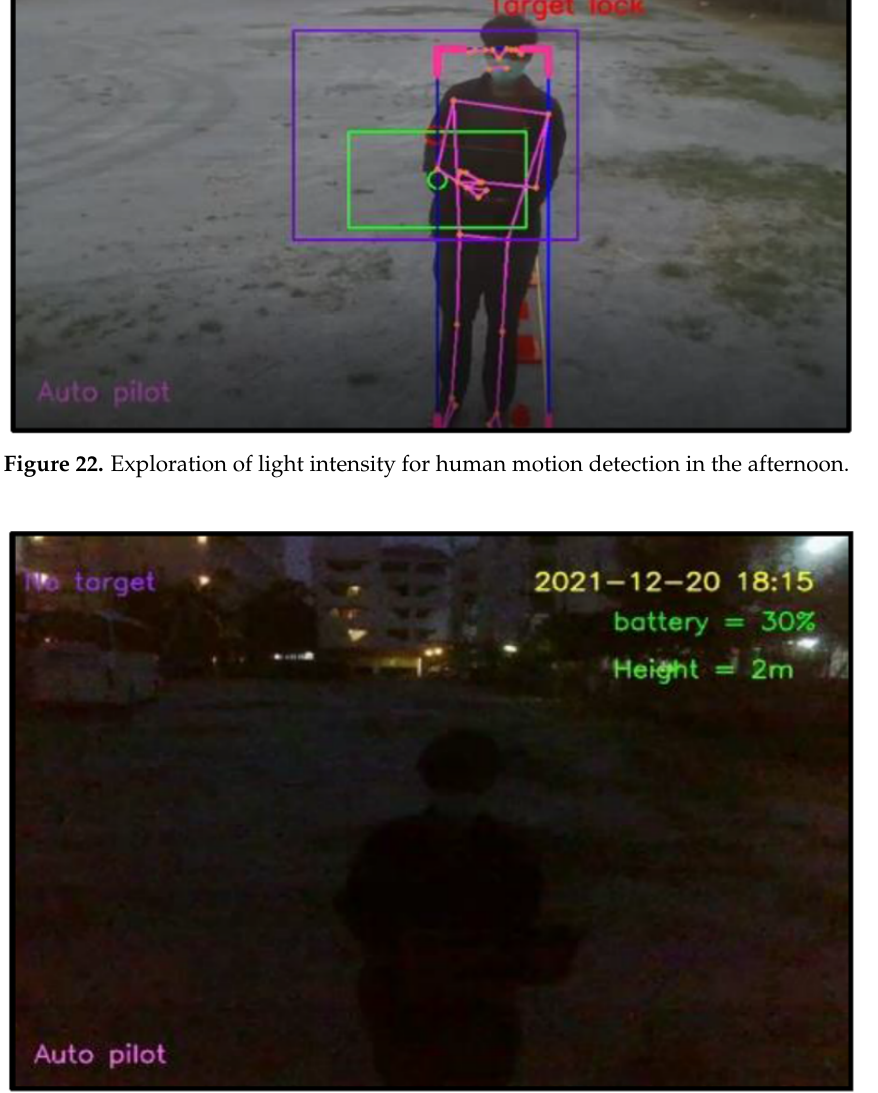
Figure 23. Exploration of light intensity for human motion detection in the evening. Figure 24 shows the experimental results over the whole day. By comparison of polynomial trend-lines, the visibility results were best in the morning, followed by in the afternoon, at noontime, and worst in the evening, respectively. The experimental results for each period are described as